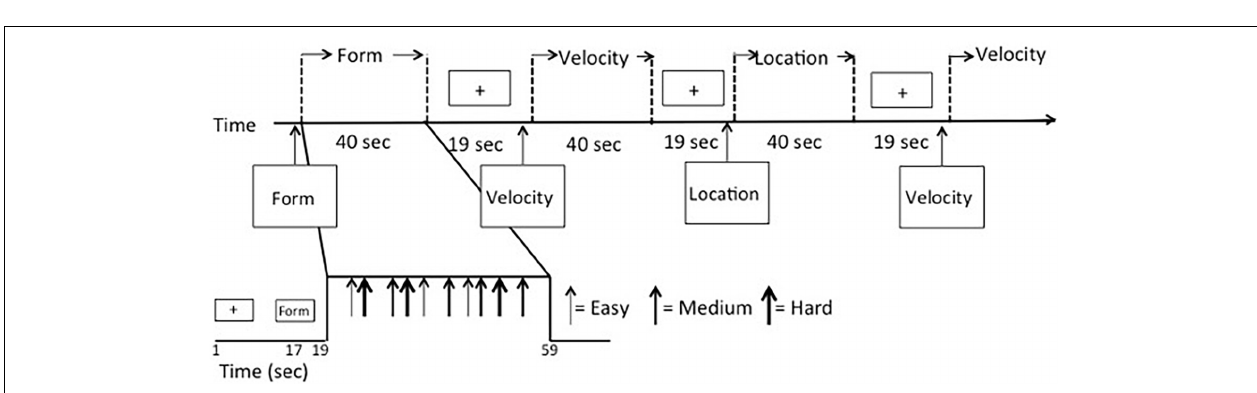
FIGURE 1 | Visual stimuli for discrimination based on spatial location (left) , shape (middle) , and velocity (right) . Arrows indicate movement velocity for the purposes of this figure and were not included in the actual test stimuli.